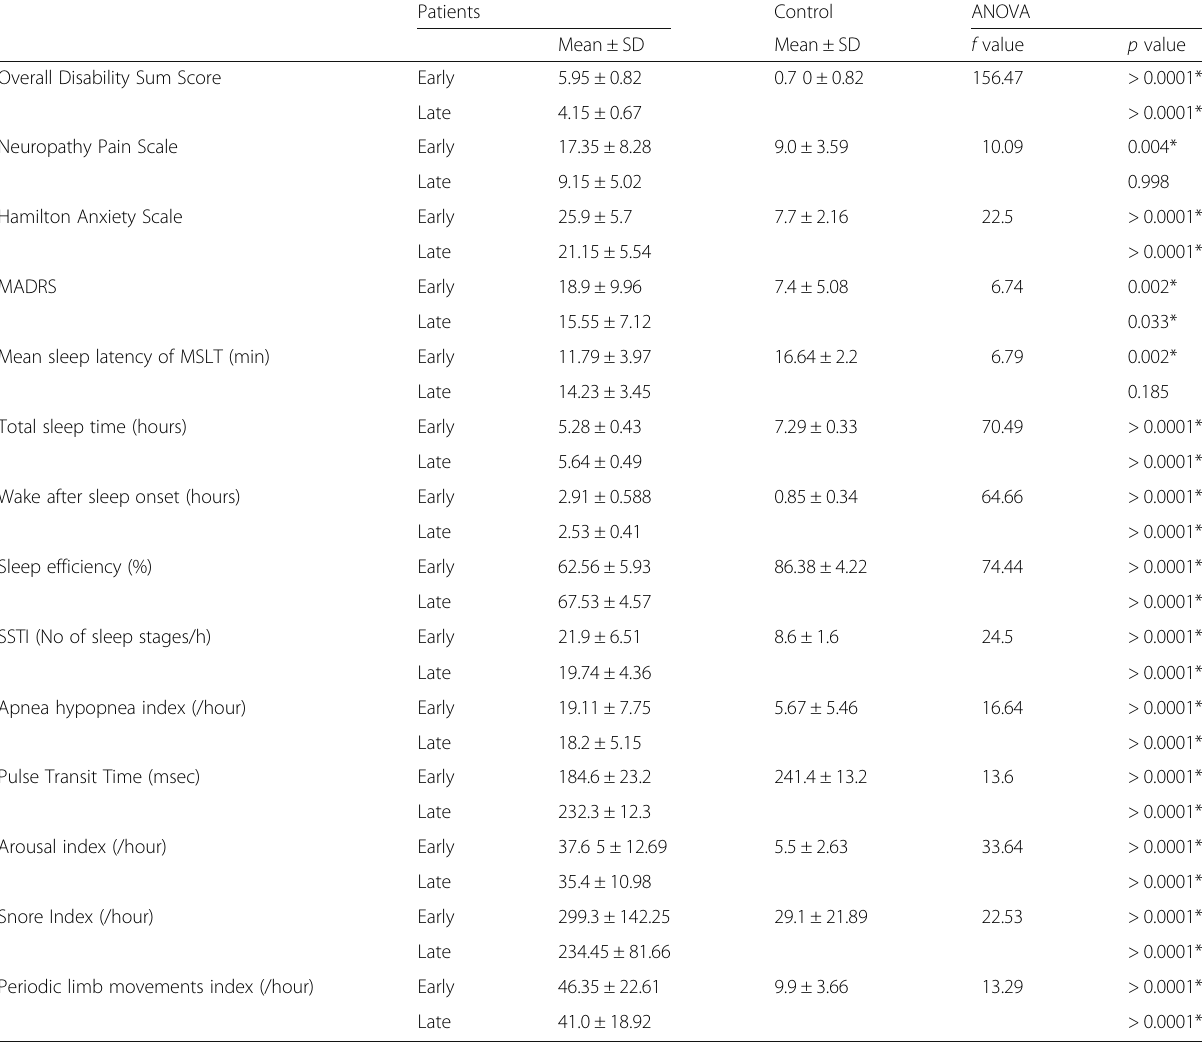
Table 1 Comparison between Gullian Barré patients and control subjects at initial assessment